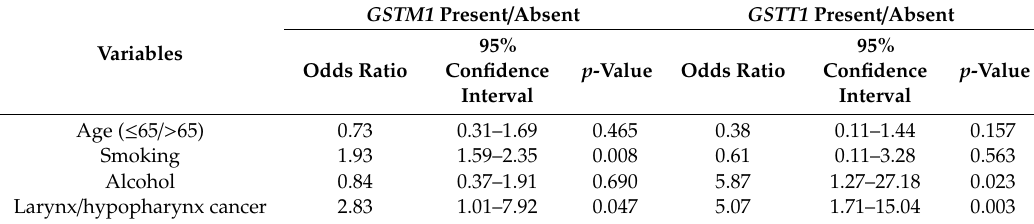
Table 4. Logistic regression model for “ GSTM1 present / absent” and “ GSTT1 present / absent”. GSTM1 Present / Absent GSTT1 Present / Absent 95% Variables p -Value Odds Ratio Odds Ratio Confidence Interval